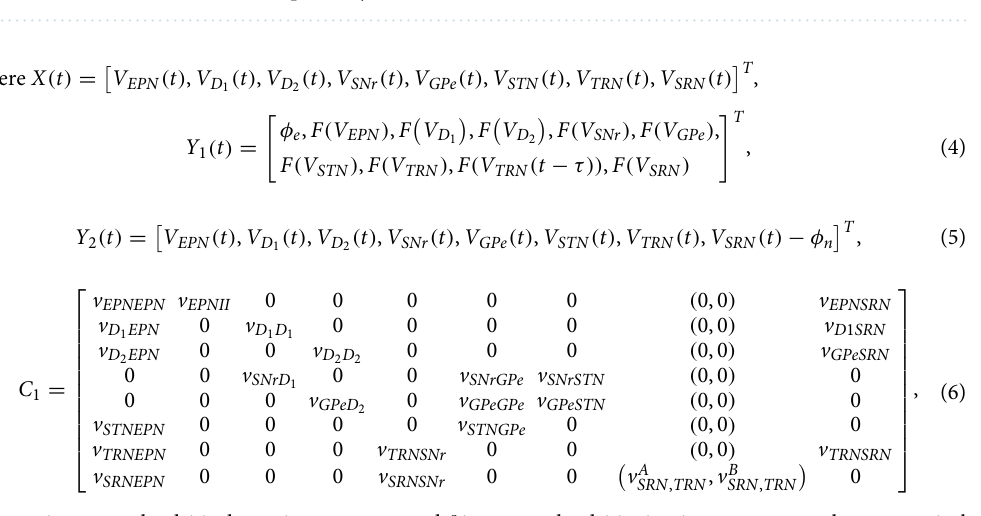
Figure 1. Structural diagram of a computational model for absent epilepsy. Nine neuron groups are shown as follows, STN subthalamic nucleus, GPe globus pallidus external, SNr substantia nigra pars reticulate, D 2 striatal D 2 neurons, D 1 striatal D 1 neurons, SRN specific relay nuclei, TRN thalamic reticular nucleus, II inhibitory interneurons, EPN excitatory pyramidal neurons. The excitatory projections are represented by purple arrow solid line. The blue lines represent inhibitory projections, where the solid and dot lines represent GABA A - mediated and GABA B -mediated,